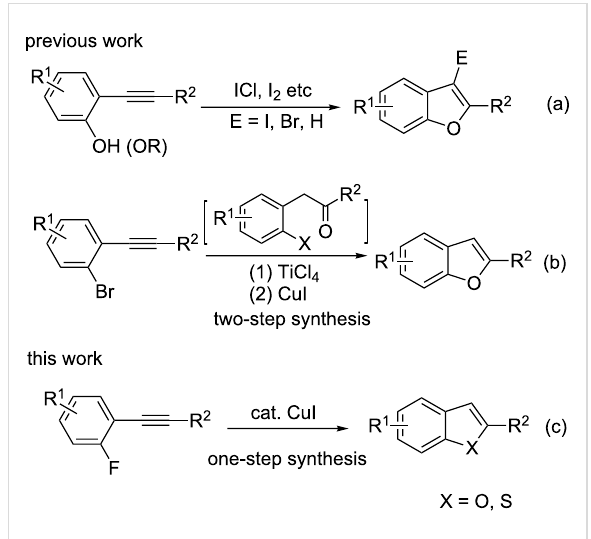
Table 1: Optimization of the reaction conditions.